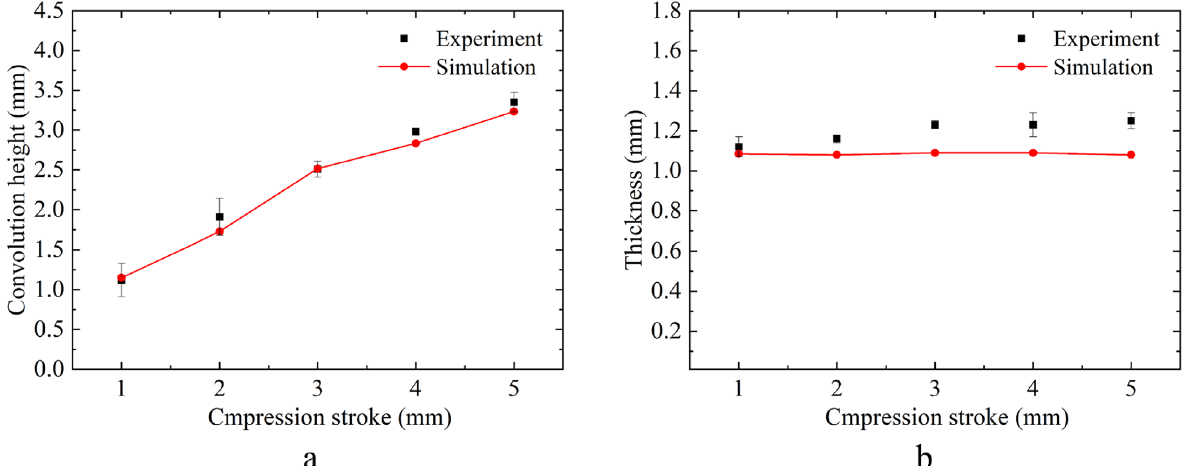
Figure 6 Comparison of simulation results and experimental data: a Convolution height and b Wall thickness at the convolution